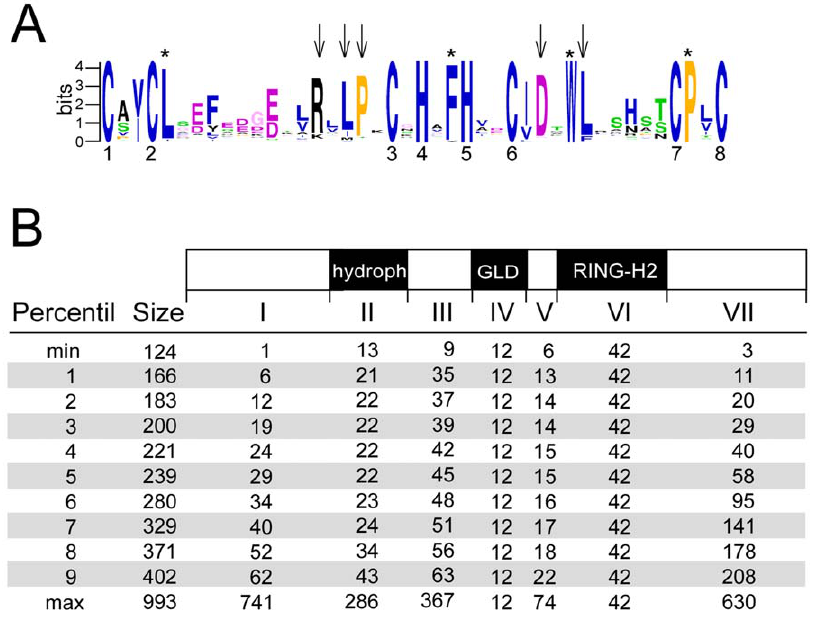
Figure 2. A broad view of domain architecture in ATLs. (A) The sequence LOGO represents the consensus sequence of the ATL RING-H2 domain. Numbers indicate the residues involved in zinc ligation, asterisks indicate the residues conserved in RING fingers, and arrowheads residues conserved in ATLs. (B) Schematic representation of a canonical ATL with its seven regions (I–VII). The second column displays the size diversification in number of amino acids sorted independently according to the statistic percentile.